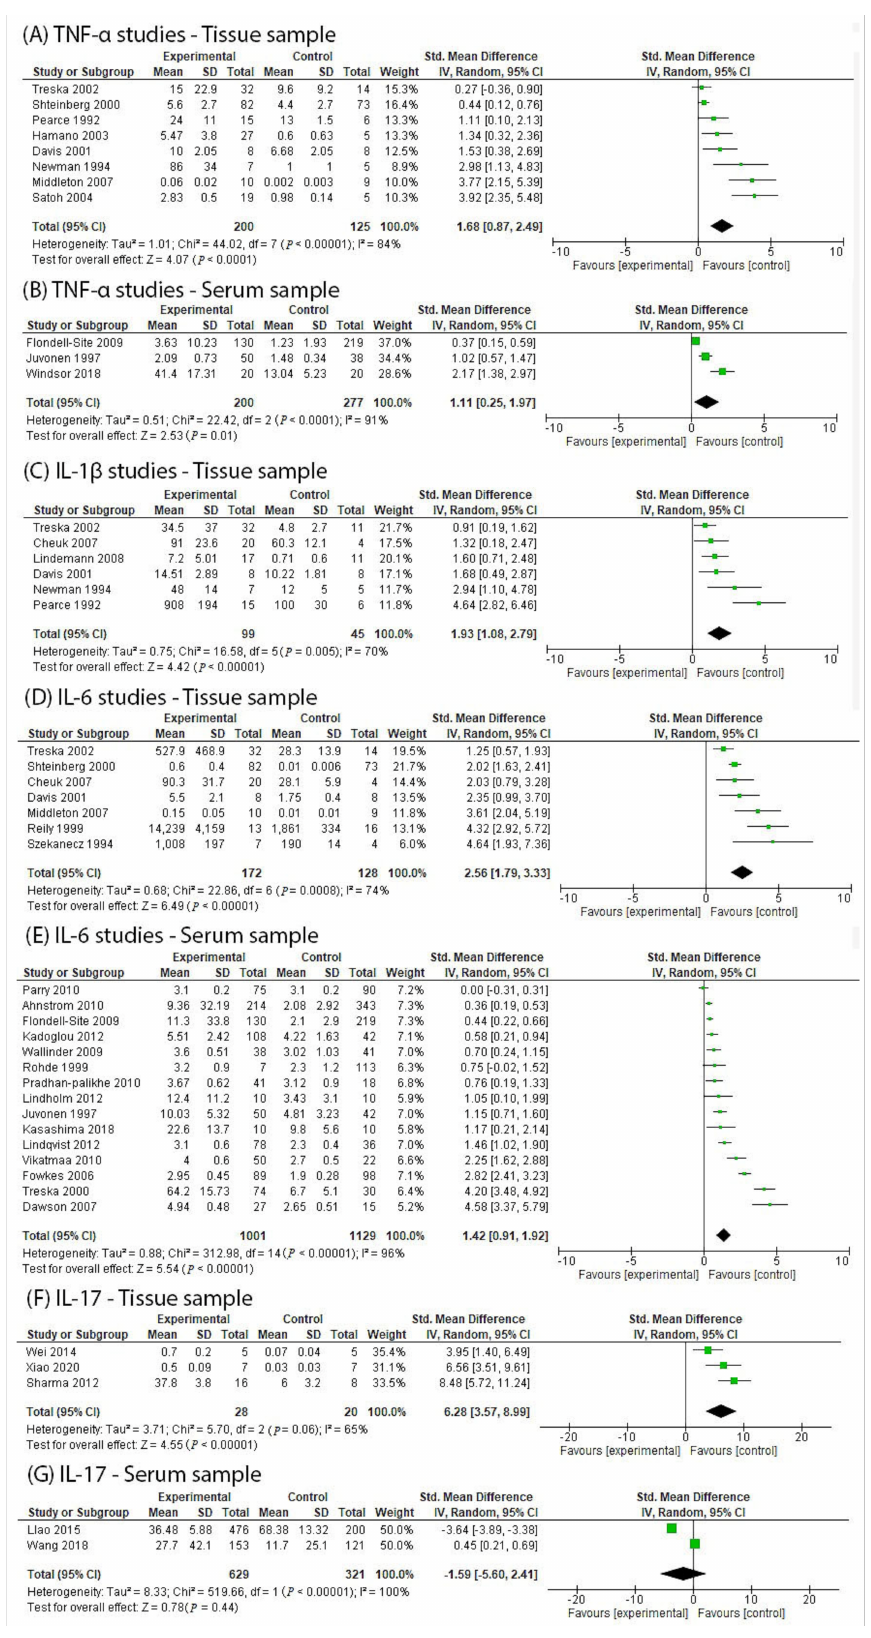
Figure 2. Meta-analysis comparing the expression levels of TNF and IL in human participants with AAA and controls. ( A ) Aortic tissue expression of TNF- α was significantly higher in AAA cases than controls [49–56]. ( B ) Serum concentration of TNF- α was significantly higher in AAA cases than controls [57–59]. ( C ) Aortic tissue expression of IL-1 β was significantly higher in AAA cases